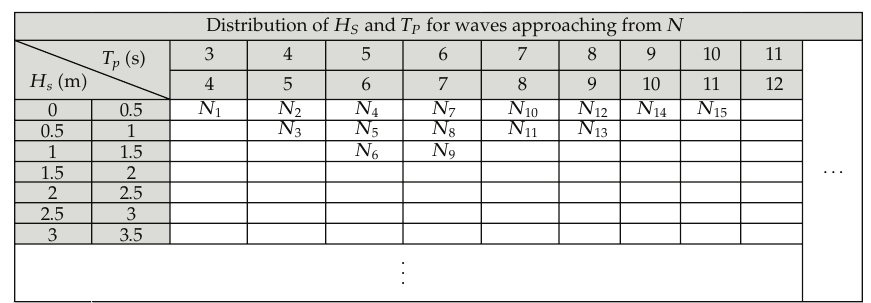
Figure 3: Example of a scatter diagram for